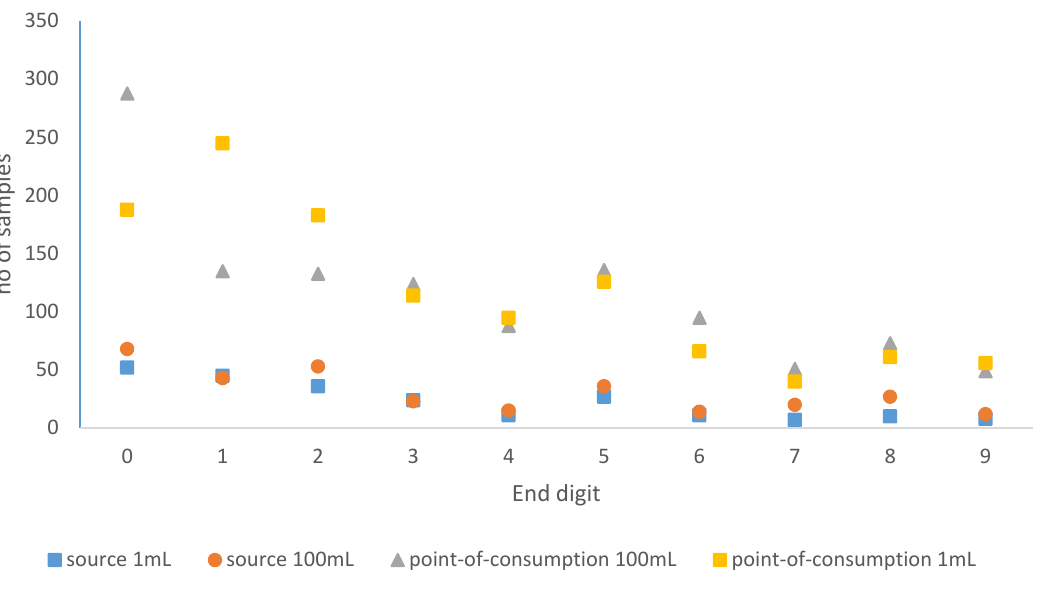
Figure 2. Distribution of end digits in E. coli colony forming unit (cfu) counts between 1 and 99 from membrane filtration of 1 mL and 100 mL source and point-of-consumption samples.